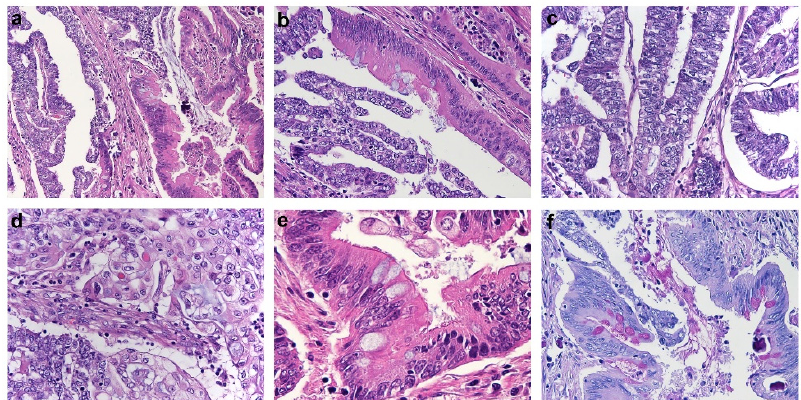
Figure 1. Histological features of Endometrial Carcinoma showing intestinal ‐ type features. ( a )